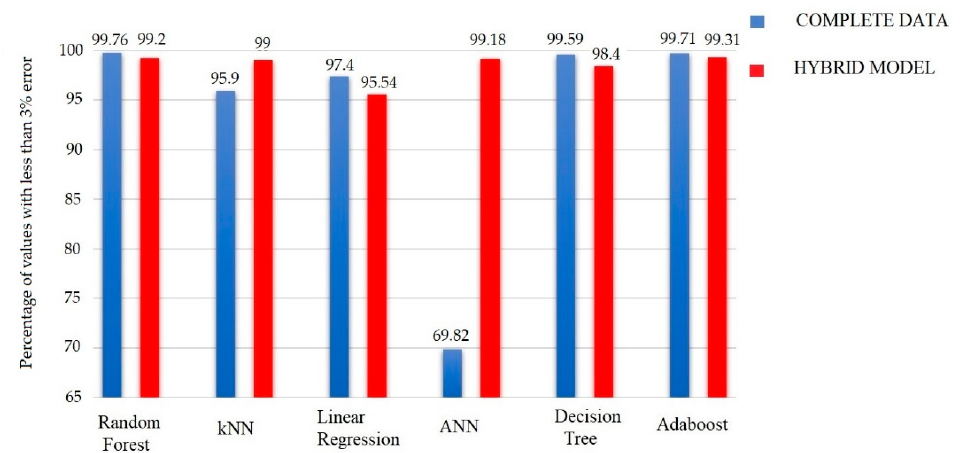
Figure 9. Comparison of percentage in predicted M/E power values (with an error of less than 3%) between the complete data set and the hybrid model.